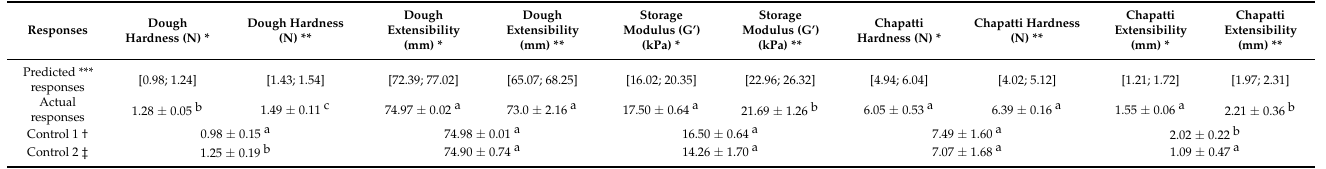
Table 3. Actual responses of dough and baked chapatti prepared with wheat flour (control) and wheat- cricket flour obtained by predicted optimal setting of all